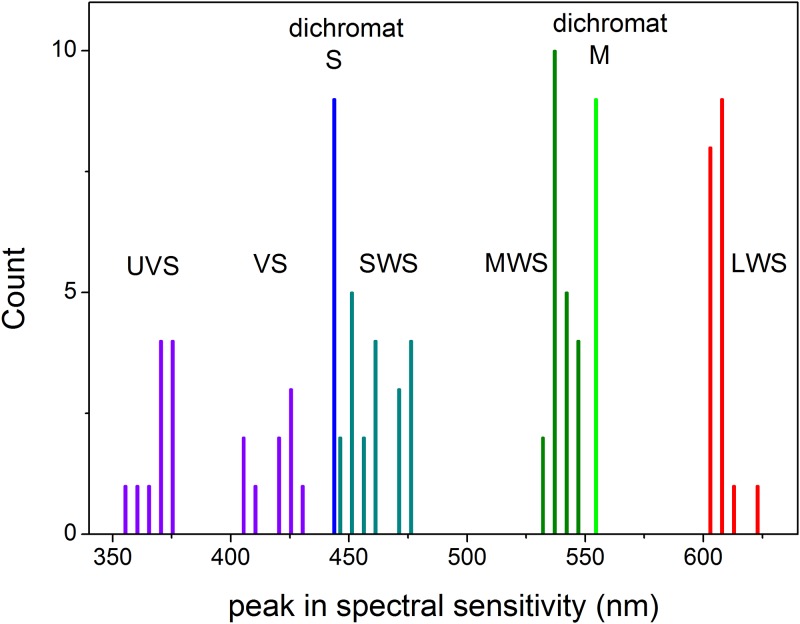
Comparison of peak spectral responses of predator and bird cones.Peak single cone spectral sensitivities for ferret S and L cones (Douglas & Jeffery, 2014) and for bird VS/UVS, SWS,MWS and LWS cones from Fig 5B in (Hart & Hunt, 2007) for 21 species of birds from 9 orders.